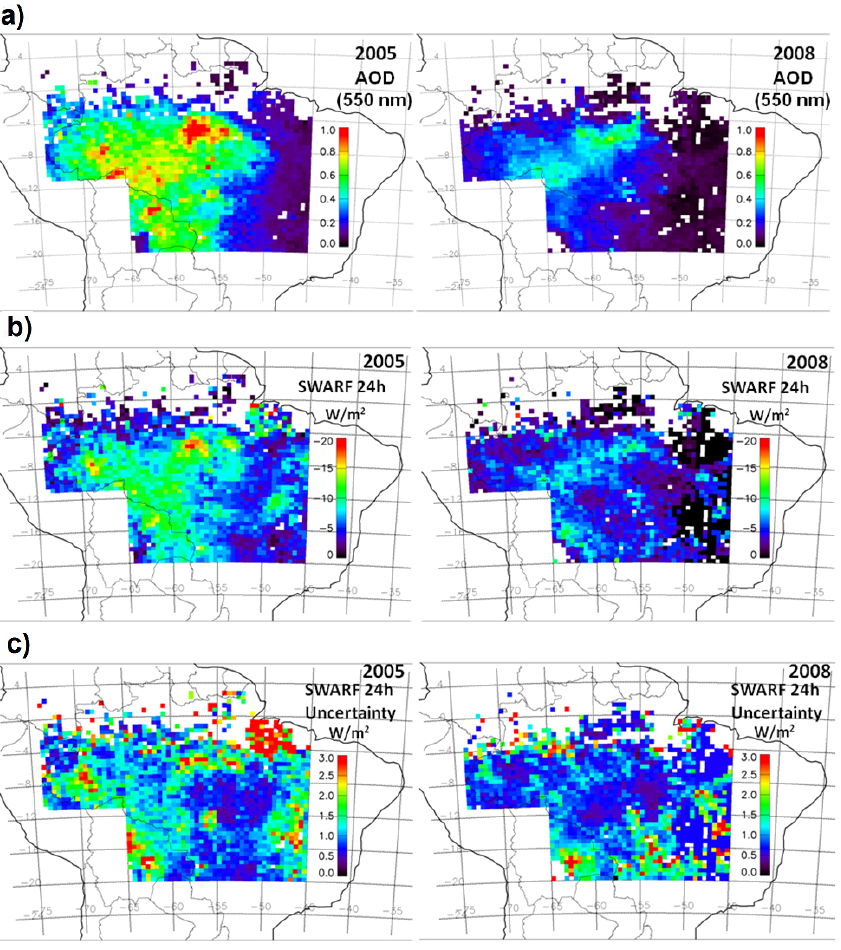
Fig. 6. Average spatial distributions during the peak of the biomass burning season of the (a) aerosol optical depth retrieved by MODIS sensor onboard Terra satellite; (b) mean daily aerosol direct radiative forcing (SWARF 24h ) ; and (c) estimated uncertainty of the SWARF 24h for the years 2005 (left) and 2008 (right). To estimate the uncertainty of the SWARF 24h the uncertainty of the points in each 0.5 ◦ × 0.5 ◦ cell was estimated by setting the reduced chi-squared equal to 1. The covariance between the flux for clean conditions ( F cl ) and the mean polluted flux observed during the studied period was also considered in this